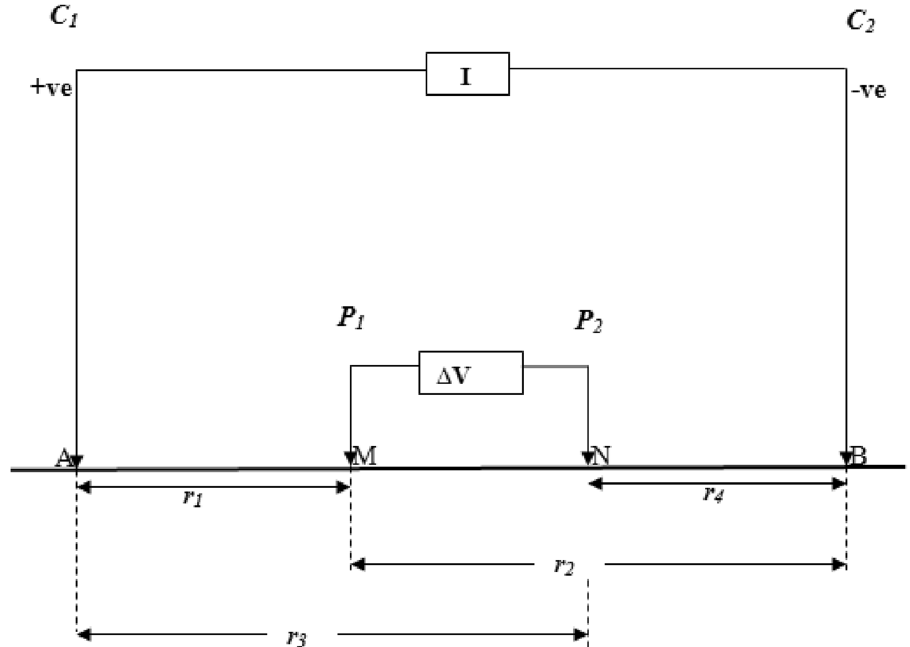
Fig. 1 Generalized form of electrode configuration in resistivity